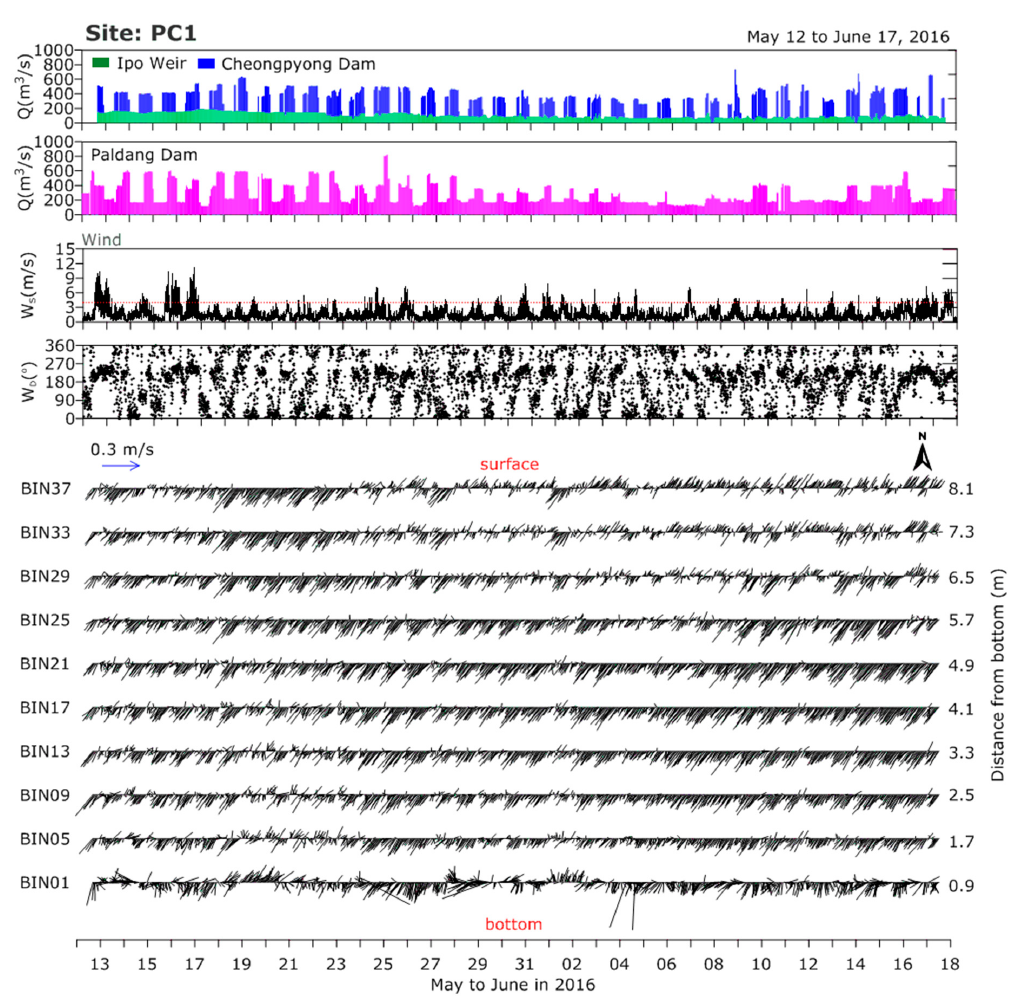
Figure 3. Discharge of the Ipo Weir (IPW), the Cheongpyeong Dam (CPD), and the Paldang Dam (PDD); wind speed and wind direction at PA1; and velocity by depth at PC1 from May 12 to June 17,